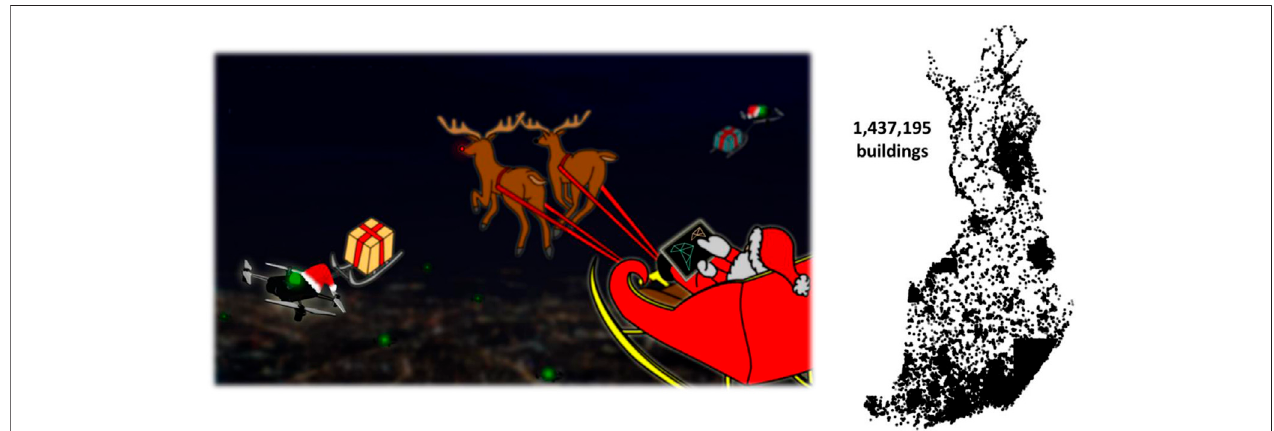
FIGURE1| TheSantaClausTSPchallengewasmotivatedbySanta ’ sneedtodeliverpresentstothechildrenineveryfamilyonChristmasEve,asisthetraditionin Finland. We used publicly available data from OSM, consisting of 1.4 million building locations. While most of the population is in south Finland, this data set has dense coverage of certain regions, such as southeast Finland. We note that this database does not cover the entirety of Finland, and there is a bias in the locations.